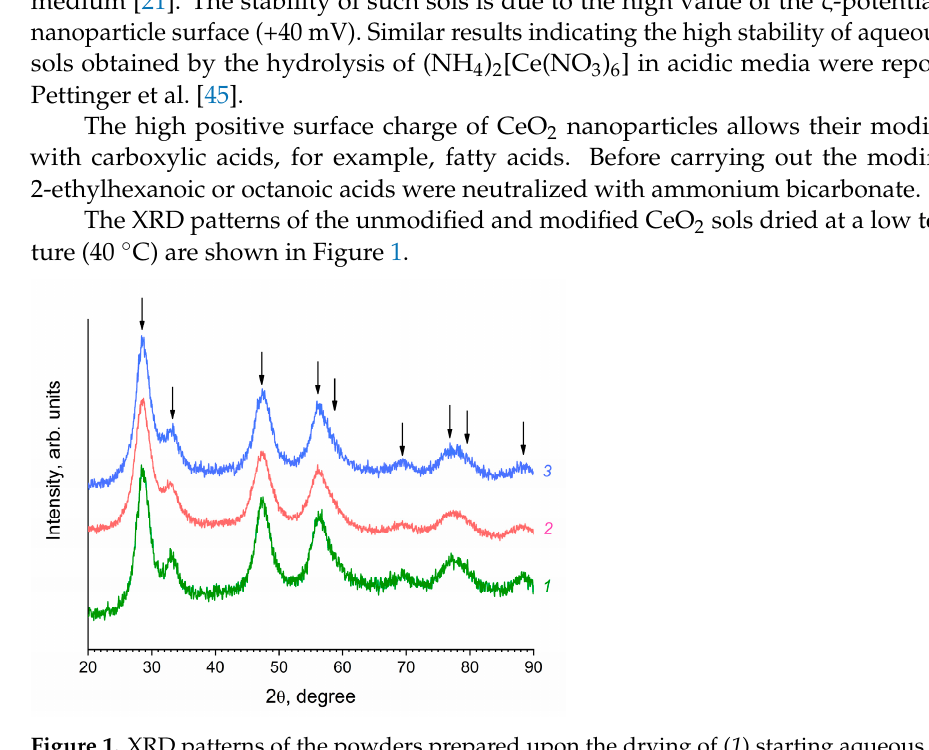
Figure 1. XRD patterns of the powders prepared upon the drying of ( 1 ) starting aqueous ceria sol and ceria sols in hexane stabilized by ( 2 ) 2-ethylhexanoic acid or ( 3 ) octanoic acid. Arrows indicate the positions of diffraction peaks corresponding to crystalline cerium dioxide (sp. gr. F m 3 m , PDF2 #00-034-0394).